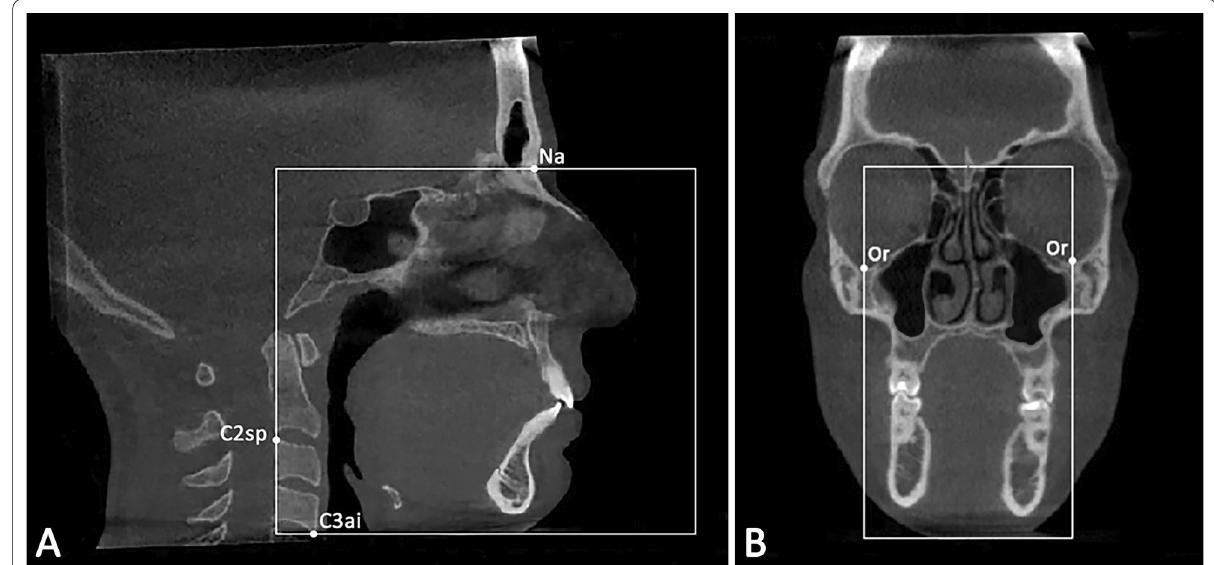
Fig. 1 Landmarks and boundaries of the volume of interest (VOI). A ) Medio-sagittal scan: Na point (most anterior point of the frontonasal junction), C3AI point (most anterior inferior point on the third cervical vertebra) and C2SP point (most superior posterior point on the second cervical vertebra); B ) Coronal scan: OR points (right and left most inferior point of the